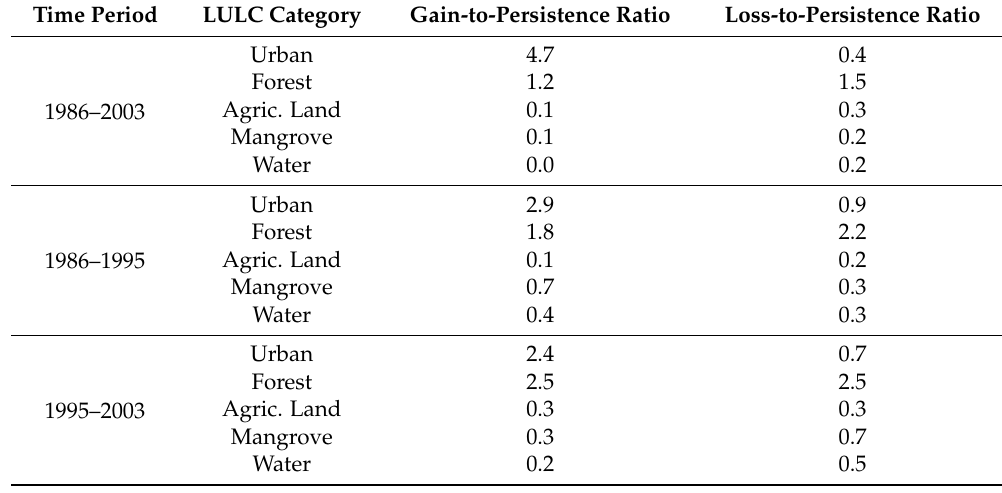
Table 11. Ratios of loss-to-persistence and gain-to-persistence for LULC conversions between